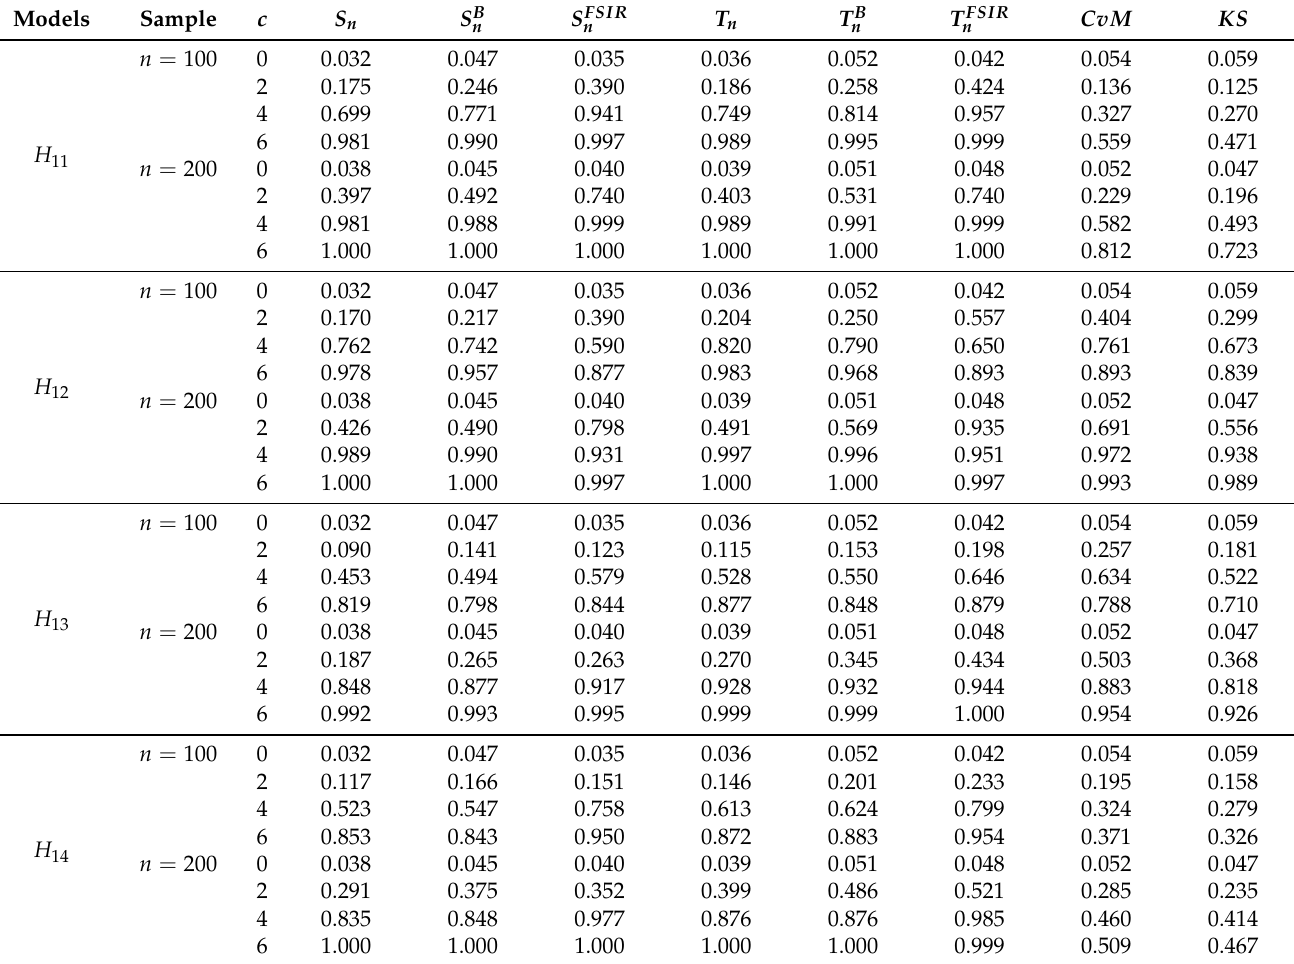
Table A1. Empirical sizes and powers of test statistics under five alternative models in Example